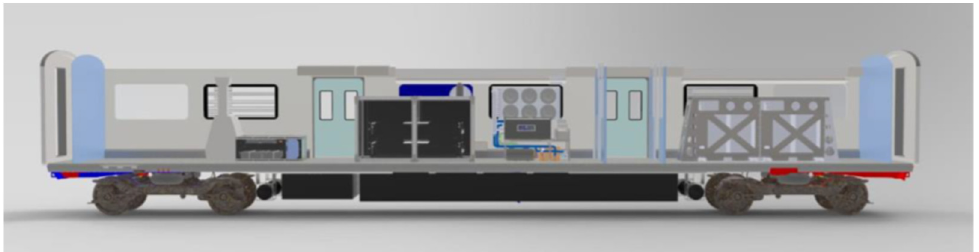
Figure 3. Design of HydroFLEX’s pantograph motor open second (PMOS) carrier.